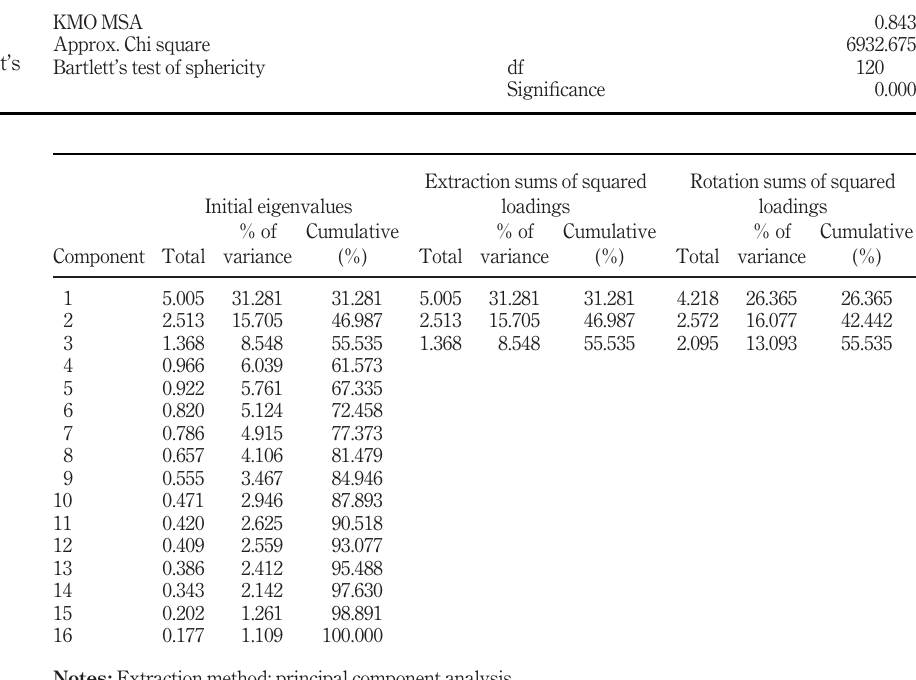
Table II. KMO and Bartlett ’ s